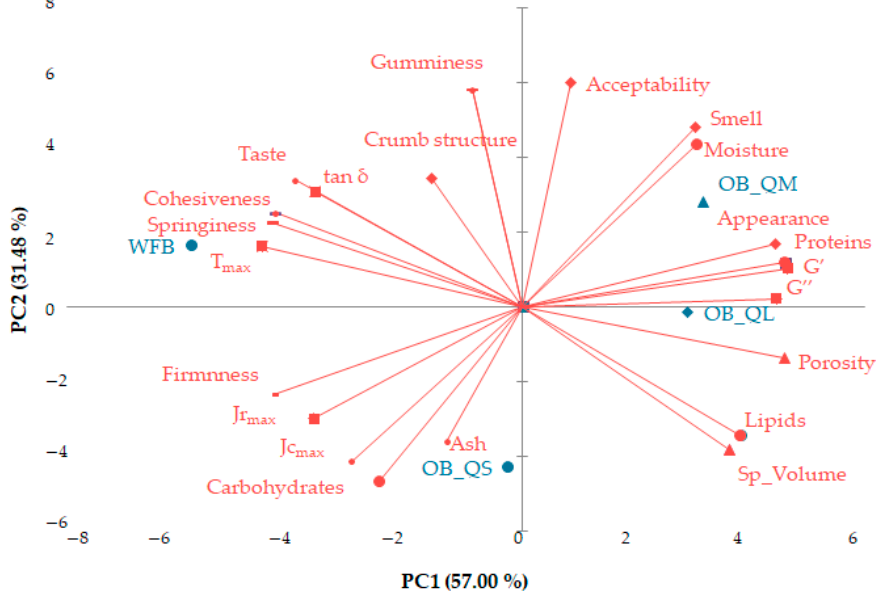
Figure 6. Principal component bi-plot analysis highlighting the relationships between dynamic dough rheological parameters and bread physical-chemical, textural and sensory characteristics. dough rheological parameters and bread physical-chemical, textural and sensory